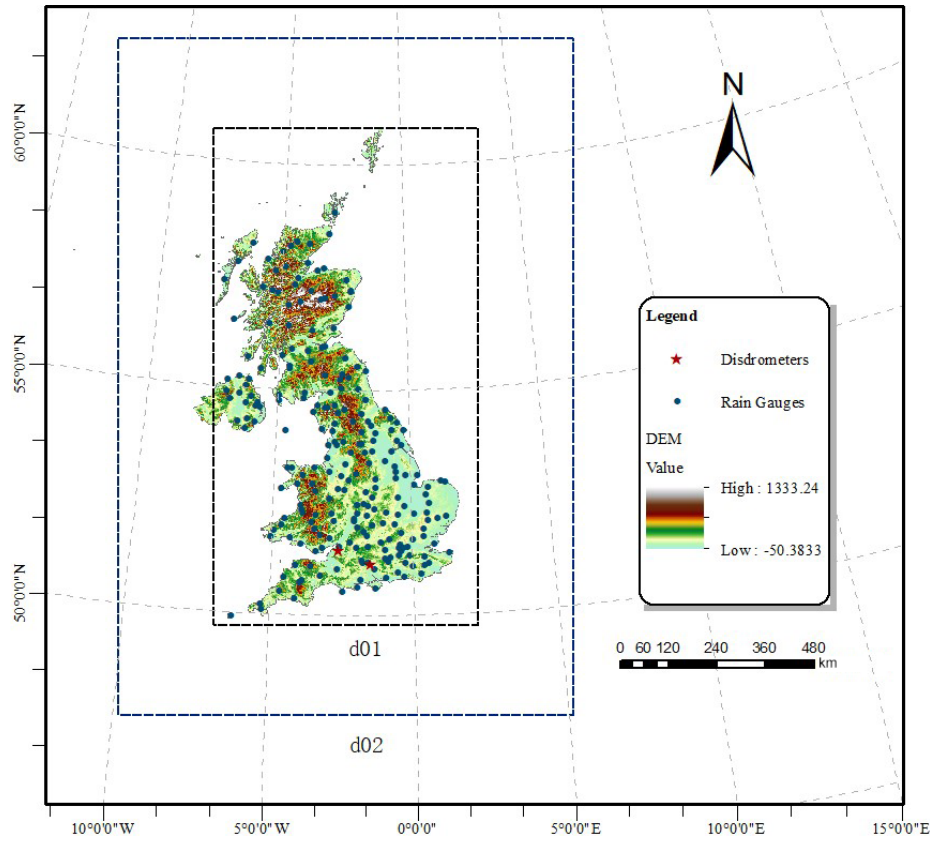
Figure 1. Location of rain gauges, Joss–Waldvogel disdrometer (JWD) at Chilbolton Observatory, OTT Parsivel 2 disdrometer (OPD) at Bristol Observatory and configurations of domain set-ups in the WRF